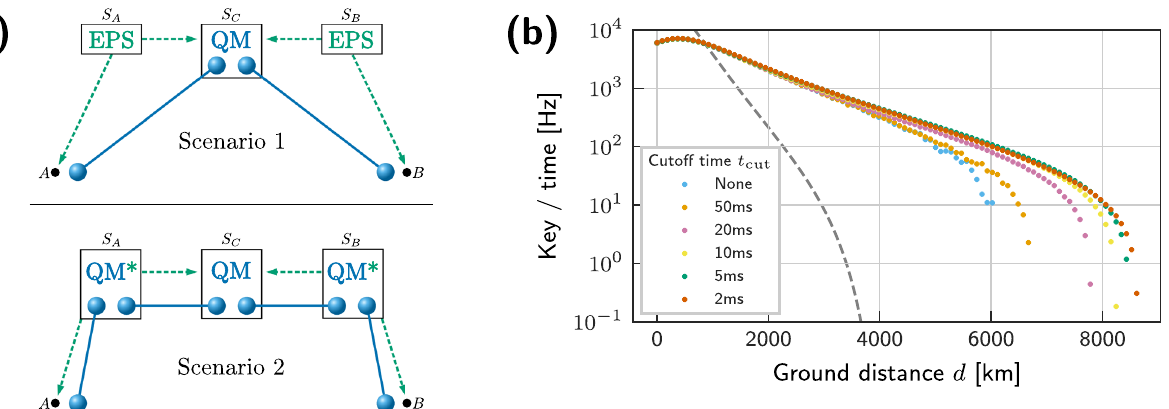
Fig. 2 Strategies for utilizing three satellites. a Illustration of the considered scenarios. Satellites S A and S B are equipped with entangled pair sources (EPS) and send qubits to the other satellite and the ground stations (dashed lines). In Scenario 1 only the central satellite S C has quantum memories and two repeater links are established. In Scenario 2 all of the satellites have quantum memories and a protocol with four repeater links are used. b Scenario 1: Choosing an appropriate cutoff time t cut — a maximum time a qubit is kept in a quantum memory — can be very bene fi cial to the key rate. The optimal value for t cut is distance-dependent and it is possible to choose a value that is too low. A dashed line indicates a BBM92 protocol with only one satellite and a clock rate of 20MHz with the same loss model. This plot is for a divergence of θ d = 6 μ rad as the effect is more pronounced in situations with high